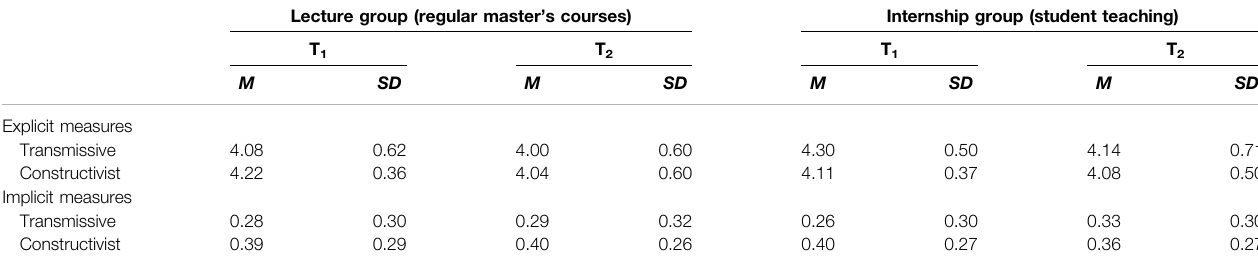
TABLE 3 | Descriptive statistics of implicit and explicit measures at T 1 (beginning of semester) and T 2 (end of semester). Lecture group (regular master ’ s courses)